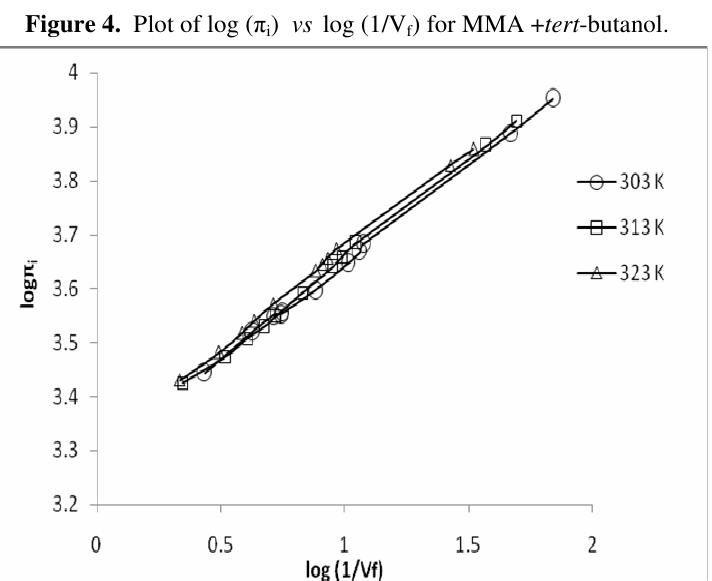
Figure 4. Plot of log ( π